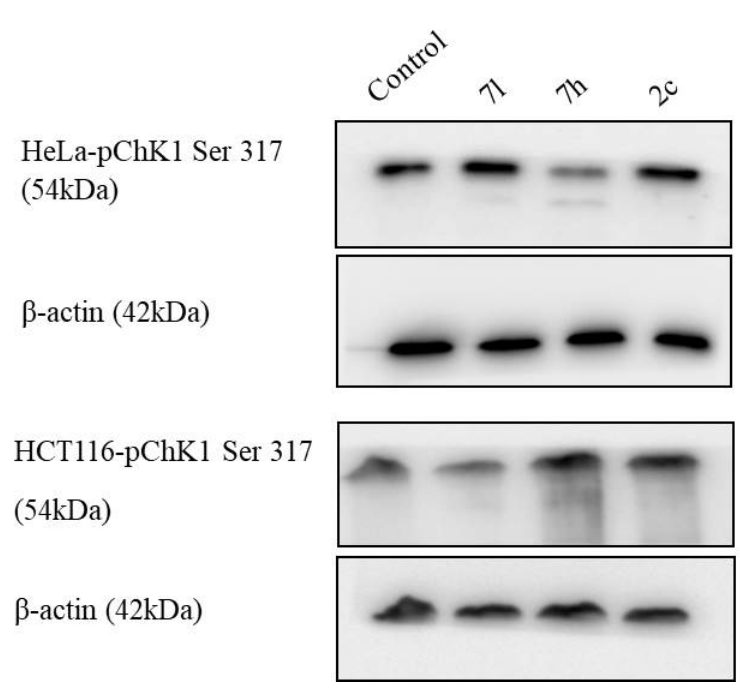
Figure 7. Inhibition of Chk1 at Ser 317 in HeLa and HCT116 cells analyzed by immunoblot assay. Further, to analyze the effect of the concentration of the compounds on the expres- sion of Chk1 and pChk1 at Ser 317 in HeLa cells, immunoblotting assay using ChK1